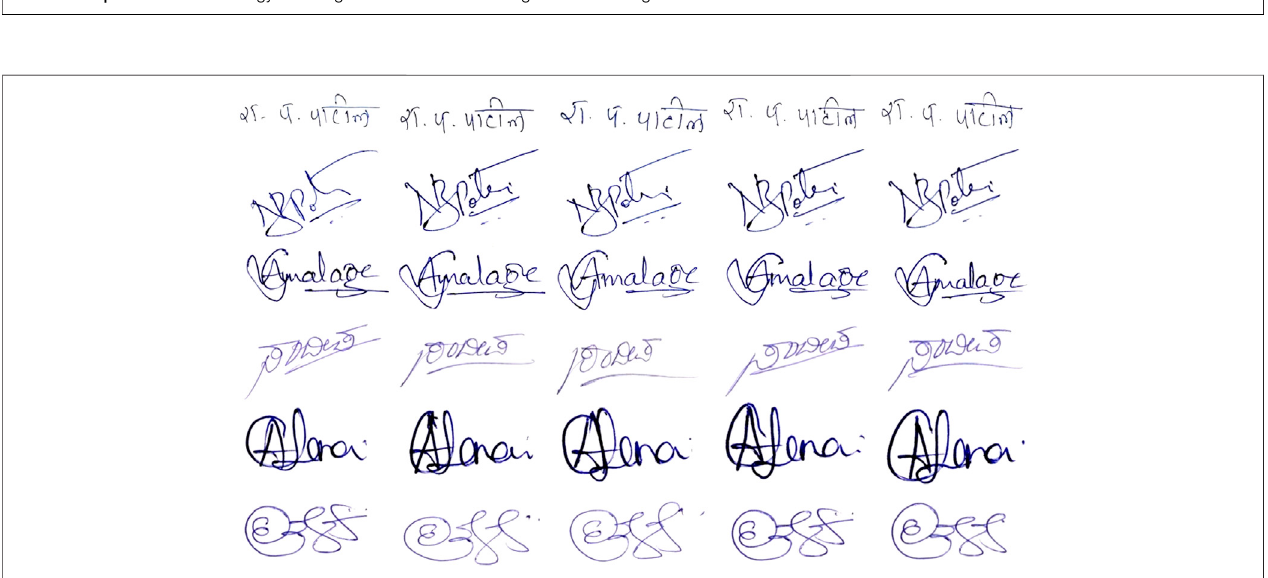
FIGURE 1 | General methodology for the gender classi fi cation using handwritten signature.